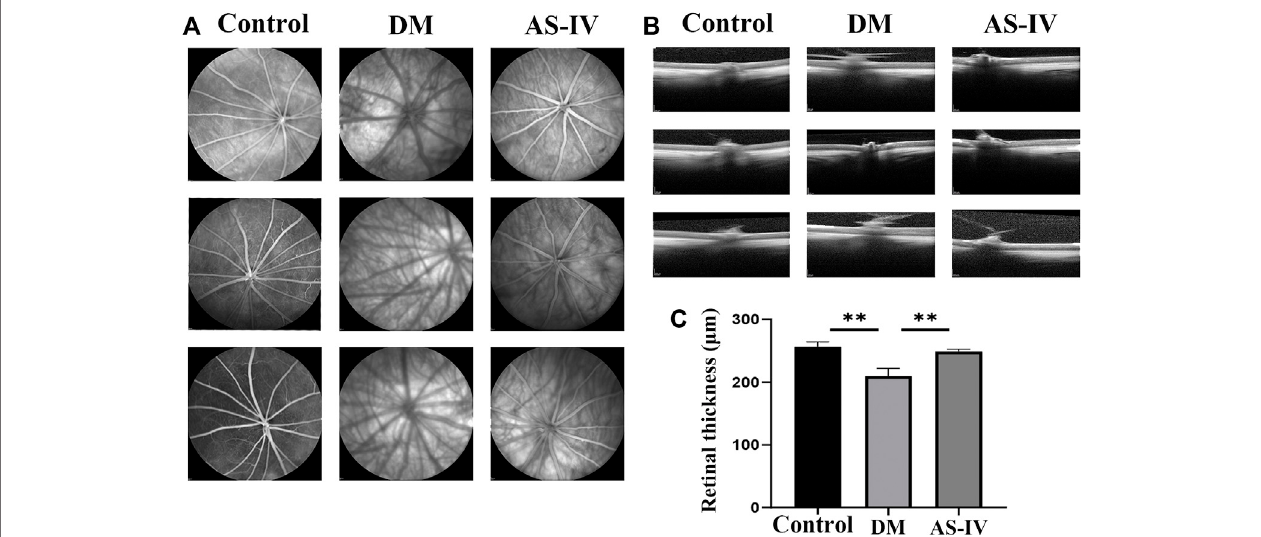
FIGURE 2 | The effect of AS-IV treatment on retinal vessels in diabetic rats. (A) Retinal vascular images of rats in control group, diabetic group and treatment groups. (B) Theimagesofretinaincontrolgroup,diabeticgroupandtreatmentgroups. (C) Quanti fi cationofretinalthicknessamongthreegroups.DM,diabetesmellitus; AS-IV, astragaloside IV. ** p < 0.01.